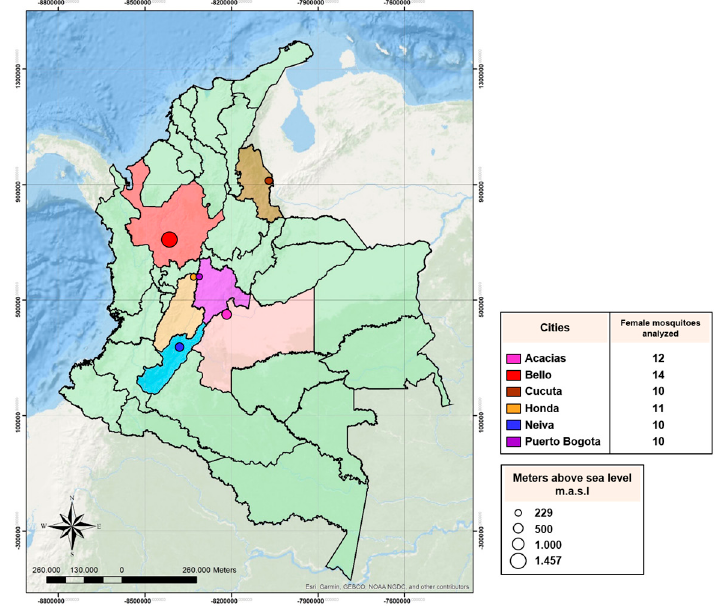
Figure 1. Map of Colombia showing cities where samples of Aedes aegypti mosquitoes were collected. The circle size denotes the altitude of each city. The number of female mosquitoes analyzed is indicated in the rectangle.